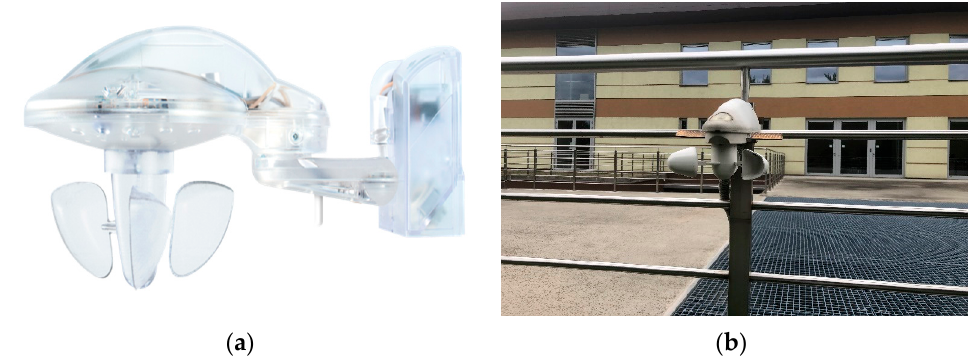
Figure 3. A Meteodata 140 S KNX weather station, ( a ) general view, ( b ) installation in the analyzed building.